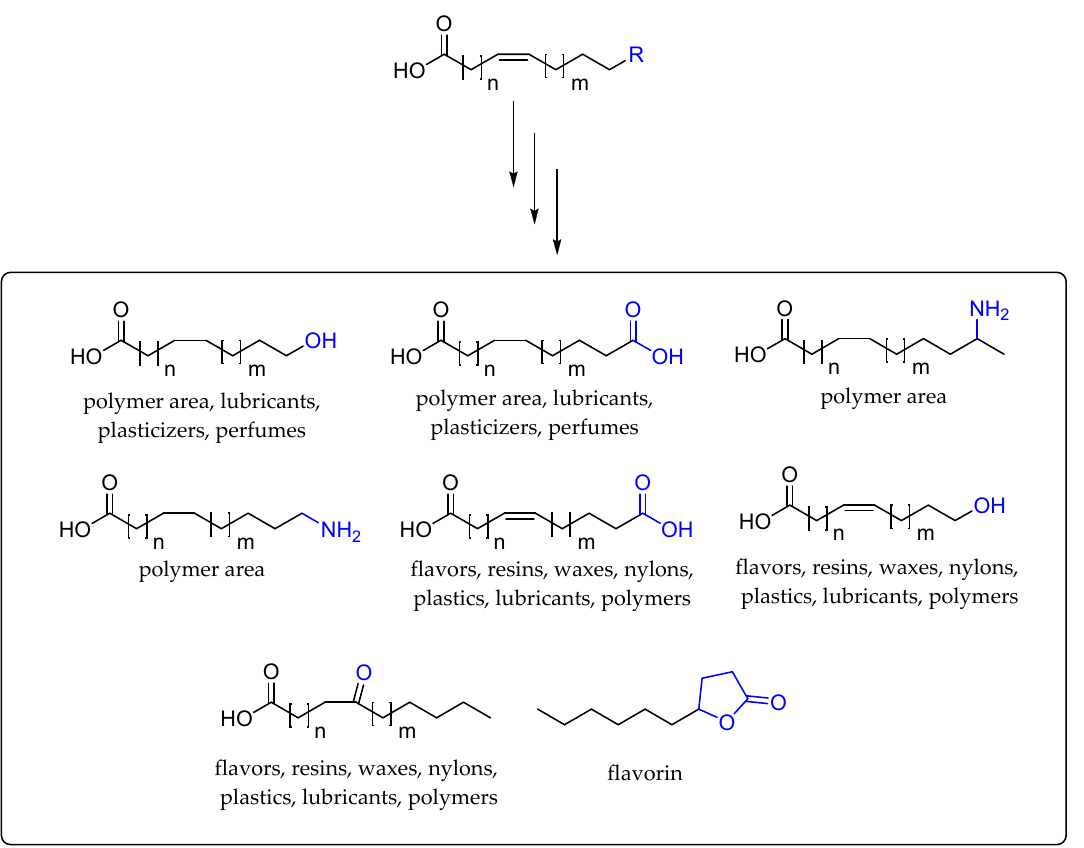
Figure 3. Collection of different molecules that were synthesized in a cascade that involve fatty acid hydratases. Listed are ω -hydroxycarboxylic acids [66] α , ω -dicarboxylic acids [68], aminocarboxylic acids [68,69], oxostearic acid [70] and lactones [2].